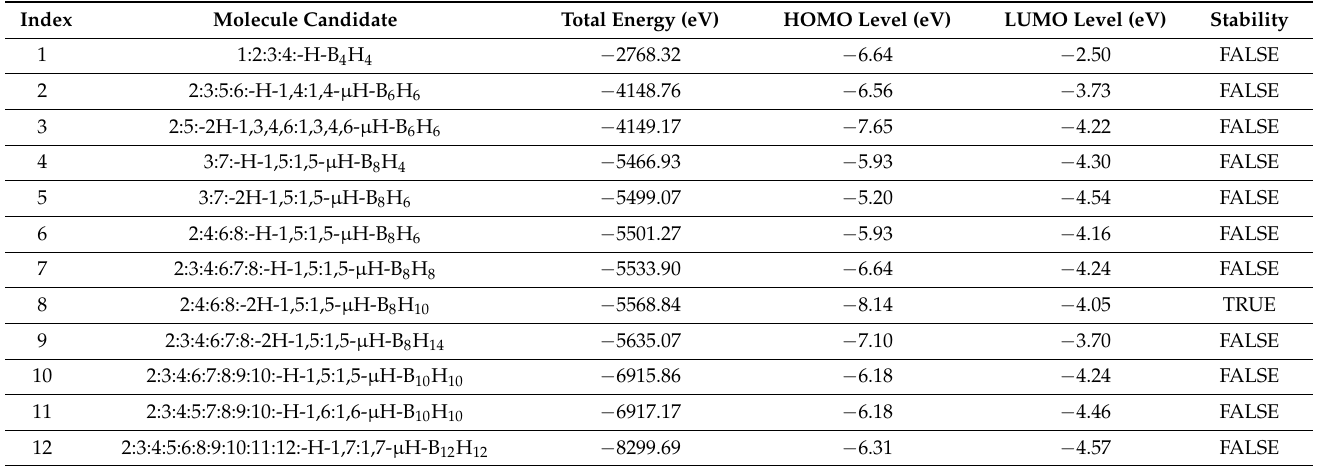
of the cyclic hydrogenated boron molecules are shown in Figure 2 and Appendix A.